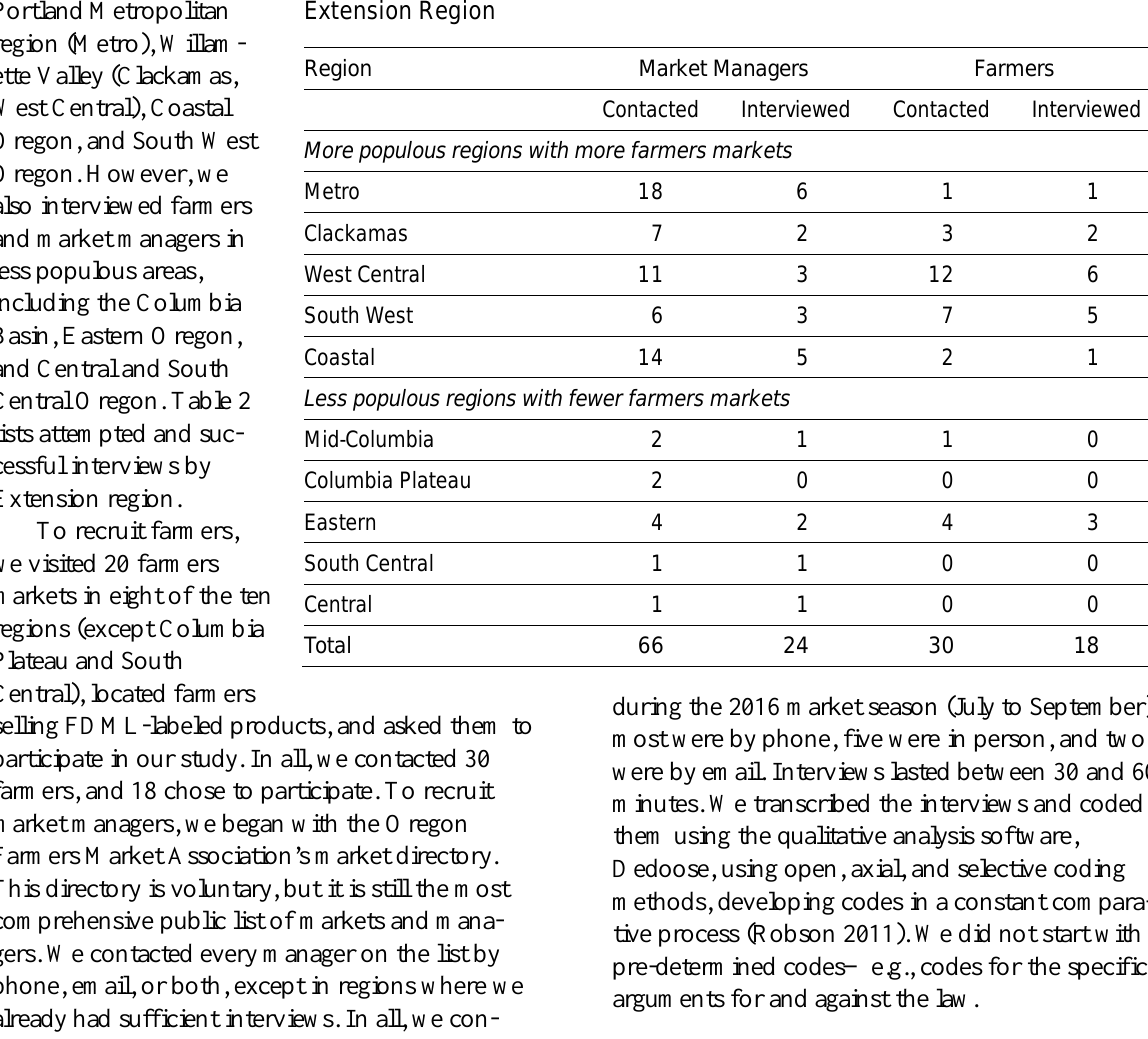
Table 2. Market Manager and Farmer Interviews by Oregon State